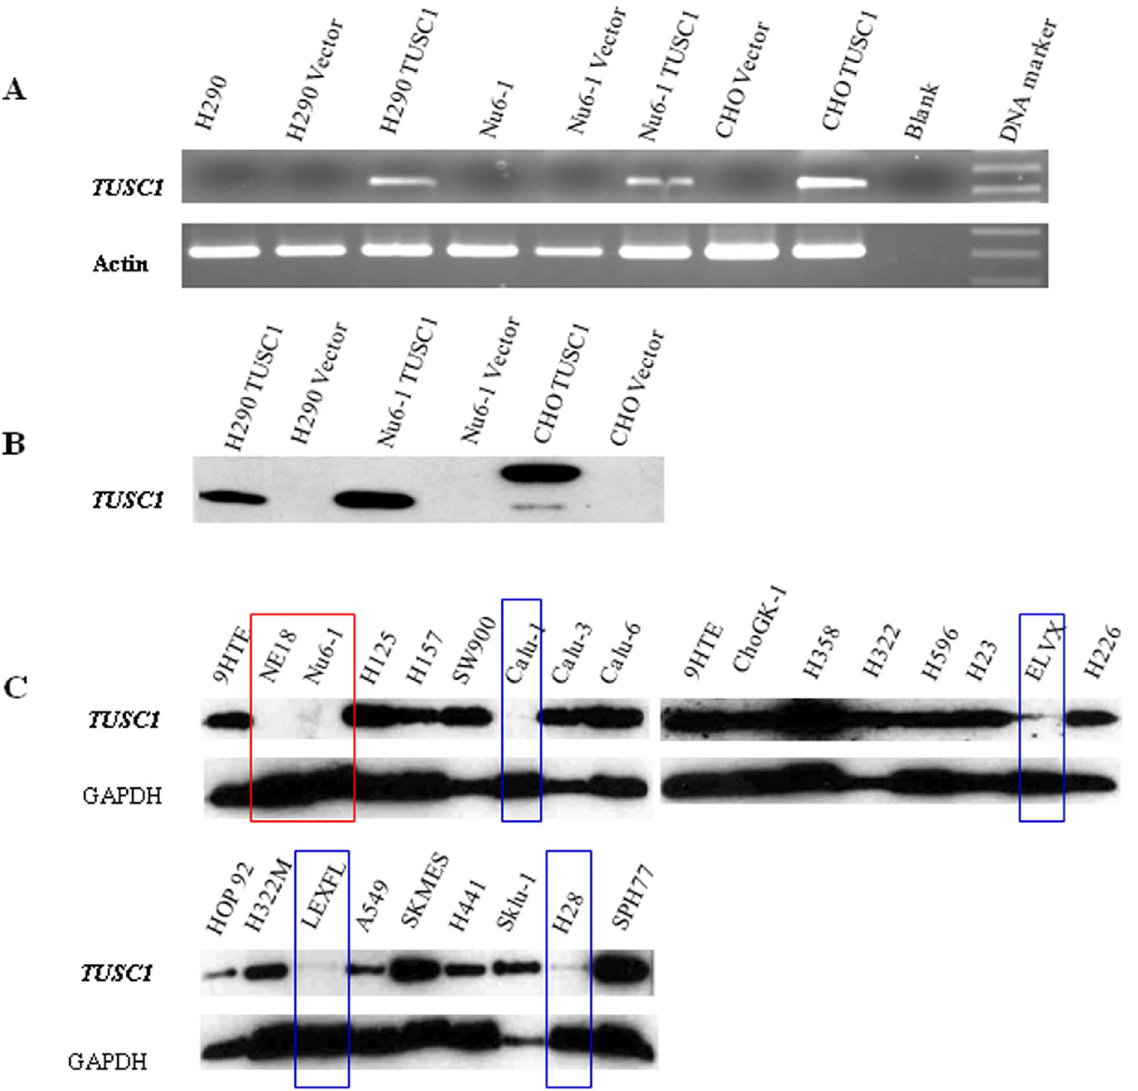
Figure 1. Expression of TUSC1 mRNA and protein in cell lines. (A–B) The tumor cell lines (H290 and Nu6-1) were stably transfected with the TUSC1 gene in pcDNA3.1 vector and CHO cells were transfected with TUSC1 in pcDNA3.1/V5-His vector. TUSC1 mRNA was amplified (RT-PCR) and exogenous protein (Western blot) was detected in all stably transfected cell lines containing TUSC1 expression clones but not the parental cell lines transfected with empty vector. (C) Western blot analysis of endogenous TUSC1 proteins in tumor cell lines. Red box: Cell lines with homozygous deletion of TUSC1 ; Green box: cell lines with reduced TUSC1 expression but without TUSC1 deletion. As an internal control for the amount of protein loaded, the same membrane was incubated with Anti-GAPDH